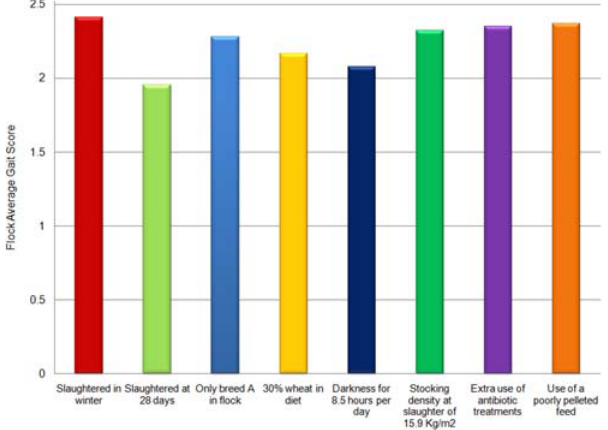
Figure 2. A modelling exercise reveals the extent to which average flock gait score might be improved (i.e. lowered from a notional average score of 2.5) by adoption of the ‘best’ management practice for each variable that we recorded within our